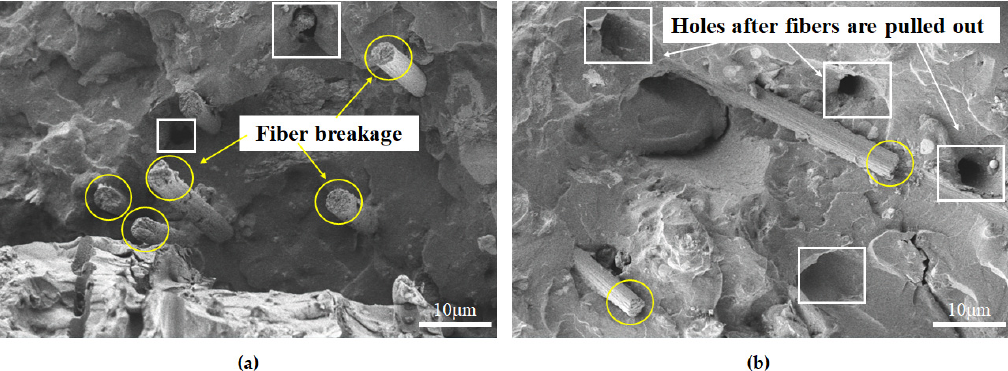
Figure 7. SEM image of typical failure section of PF-PUC specimen. ( a ) − 40 °C; ( b ) +40 °C.